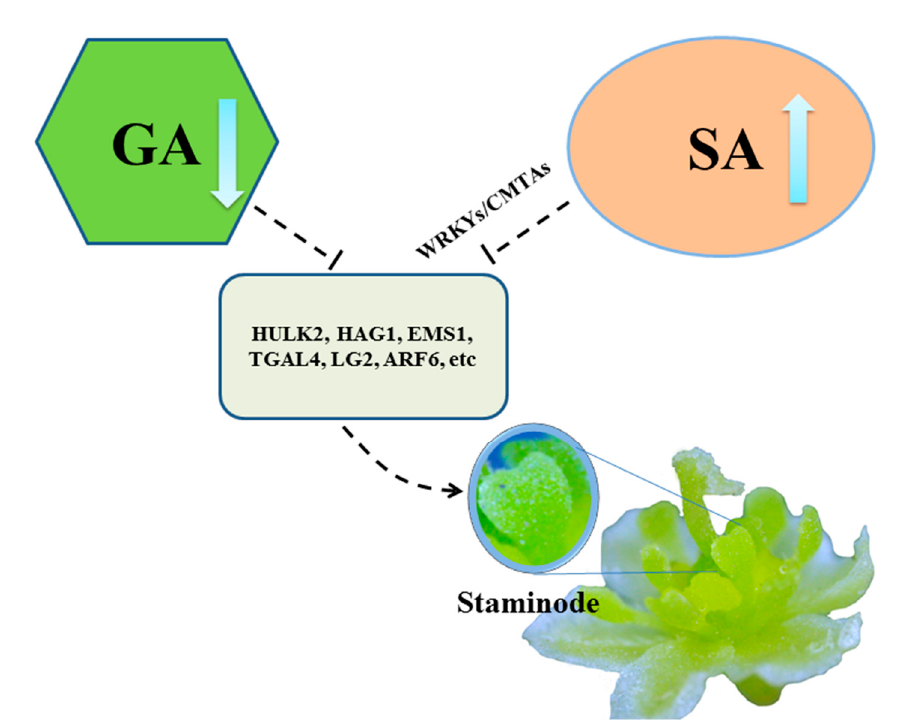
Figure 5. Hypothetical model for stamens abortion of female flowers in L. cubeba . The proposed pathway involved in SA biosynthesis (organ oval) or gibberellin (GA) biosynthesis (green polygon), then the normal expression of stamens developmental genes such as HULK2 , HAG1 , EMS1 , TGAL4 , LG2 and ARF6 (dark green square), resulting in the formation of